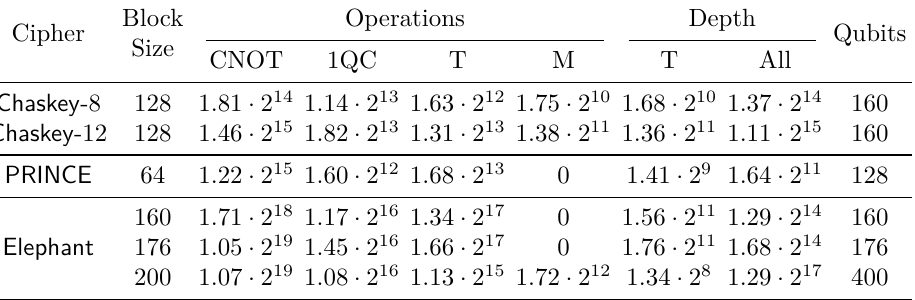
Table 1: Quantum circuit costs for the circuits we analyze. “1QC” are single-qubit Clifford operations and “M” are